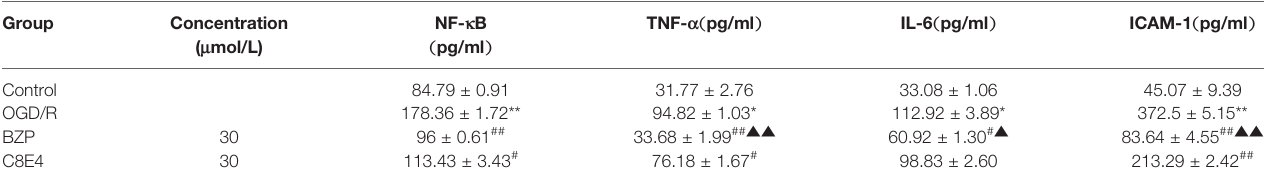
TABLE 6 | Effect of BZP on the expression of NF- k B, TNF- a , IL-6 and ICAM-1 in OGD/R induced PC12 cells injury.